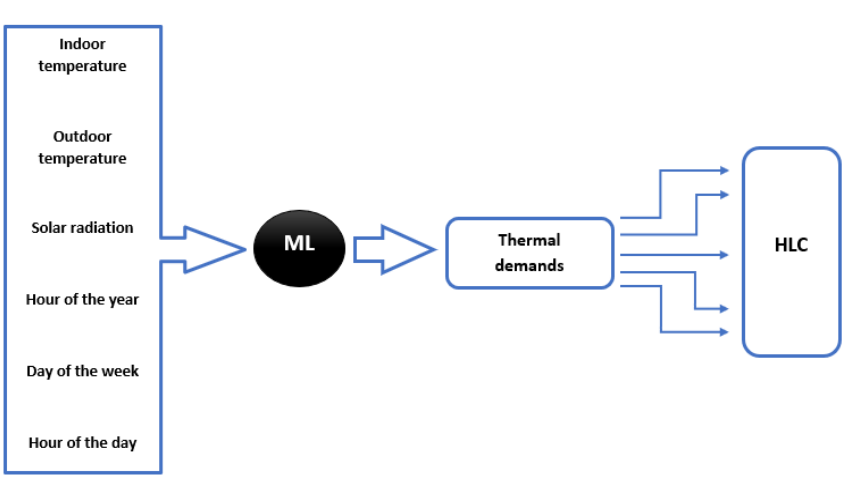
Figure 2. Summary of the training and prediction process. On the left, the input variables of the models. On the right, the objective estimations of the Heat Loss Coefficient